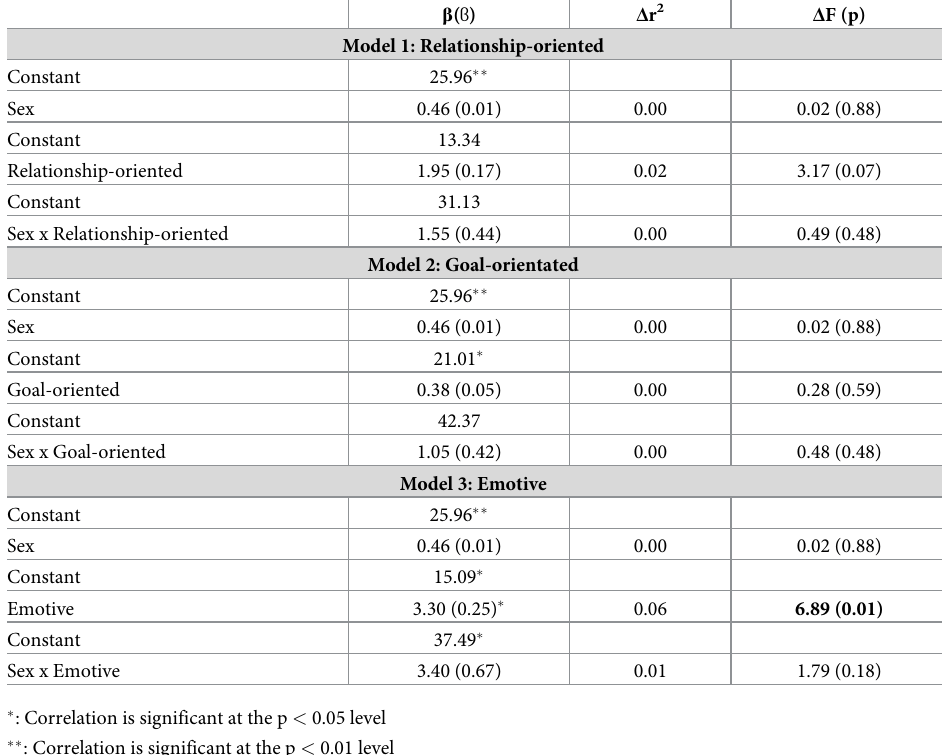
Table 5. Summary of regression analysis for predicting pain interference by sex and GPES subscales